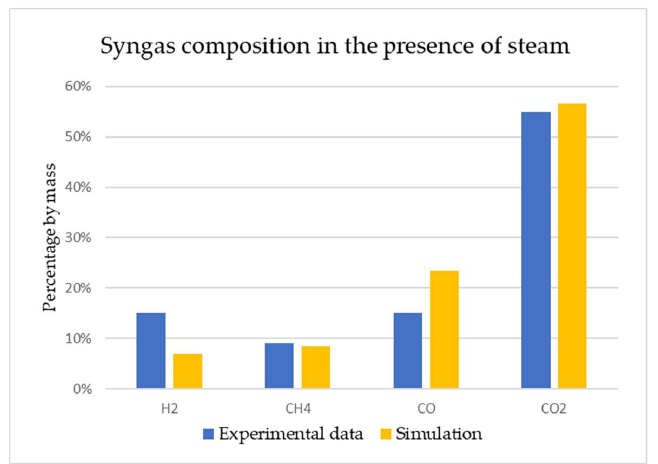
Figure 5. Percentage by mass of the syngas components in case steam has been added to the reac-